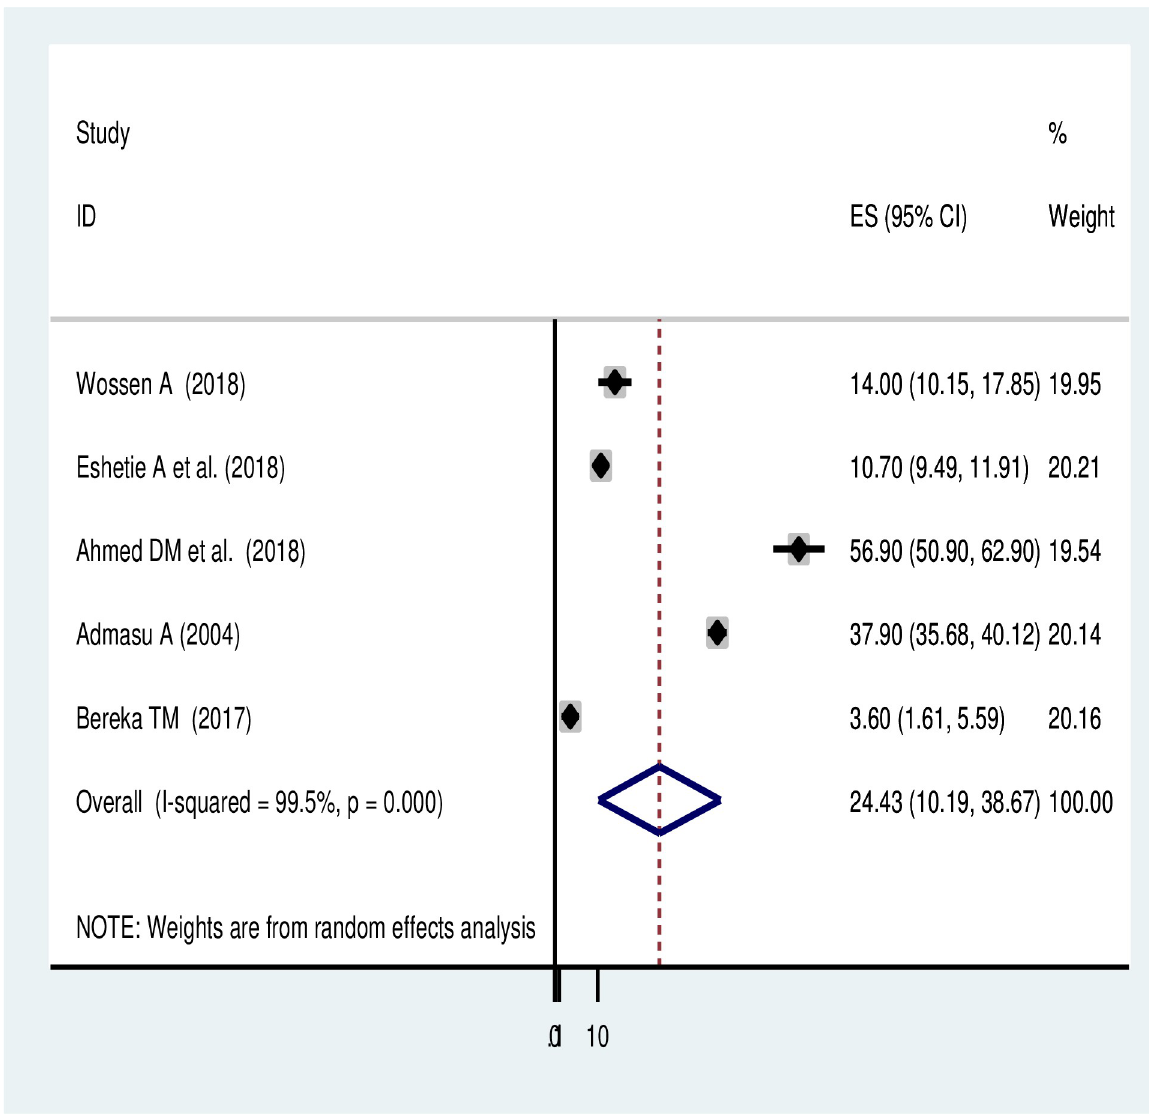
Fig 5. Forest plot of shock associated with uterine rupture in